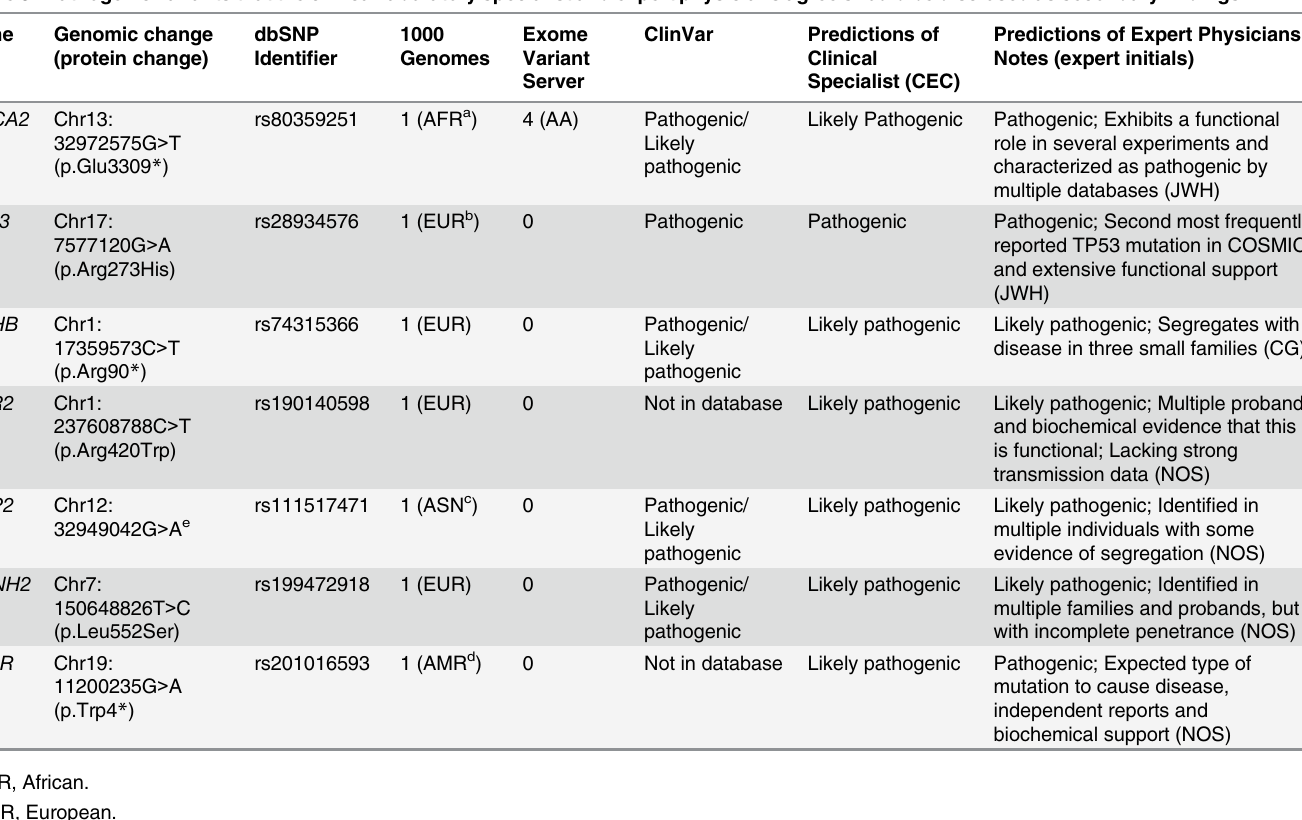
Table 3. Pathogenic variants that the clinical laboratory specialist and expert physicians agree should be disclosed as secondary findings. Gene Genomic change dbSNP 1000 (protein change) Identi fi er